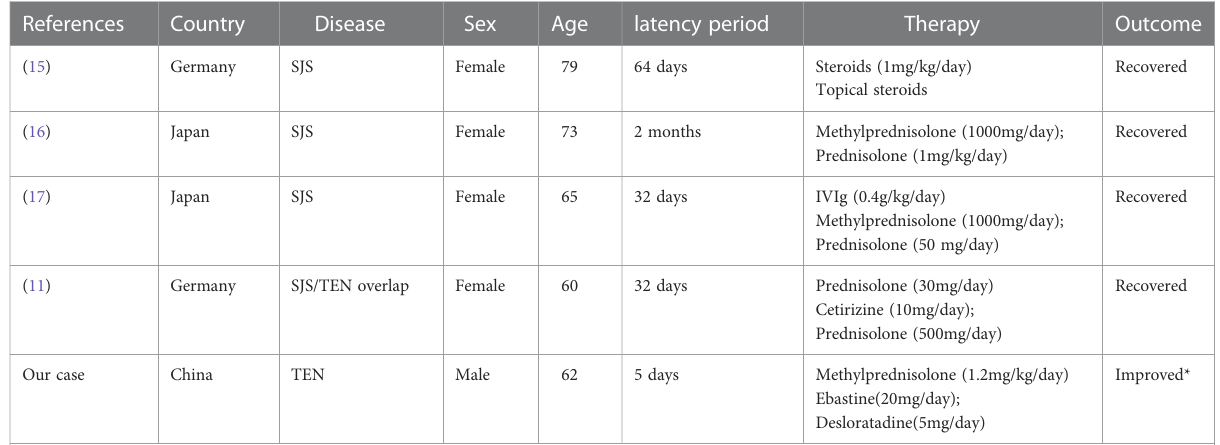
TABLE 1 Case report of SJS/TEN associated with